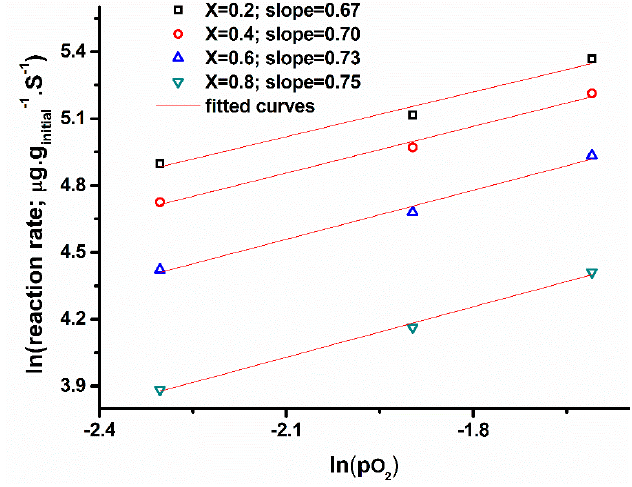
Figure 9. Linear fits of the reaction order of oxygen partial pressure at carbon conversions of 0.2–0.8.